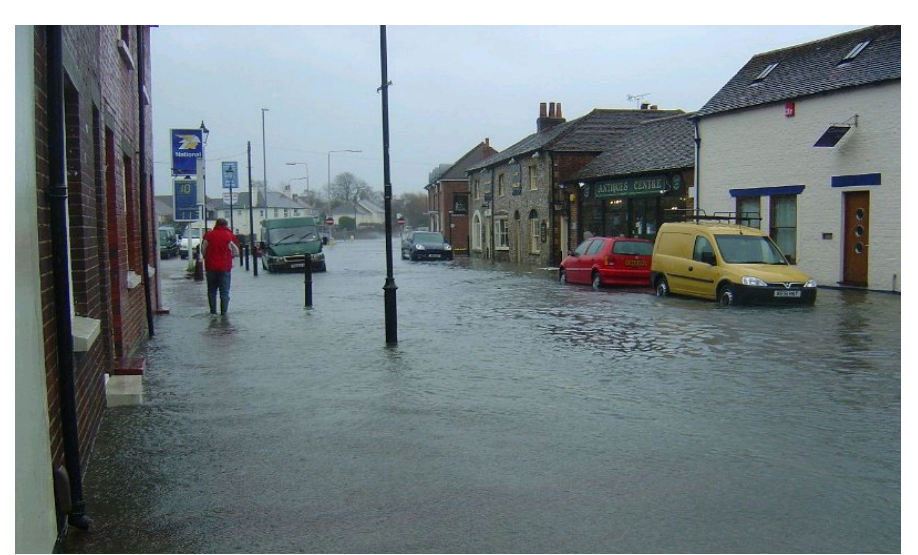
Figure 7. Flood waters surround properties in Emsworth, Borough of Havant near high water on 10th March 2008,